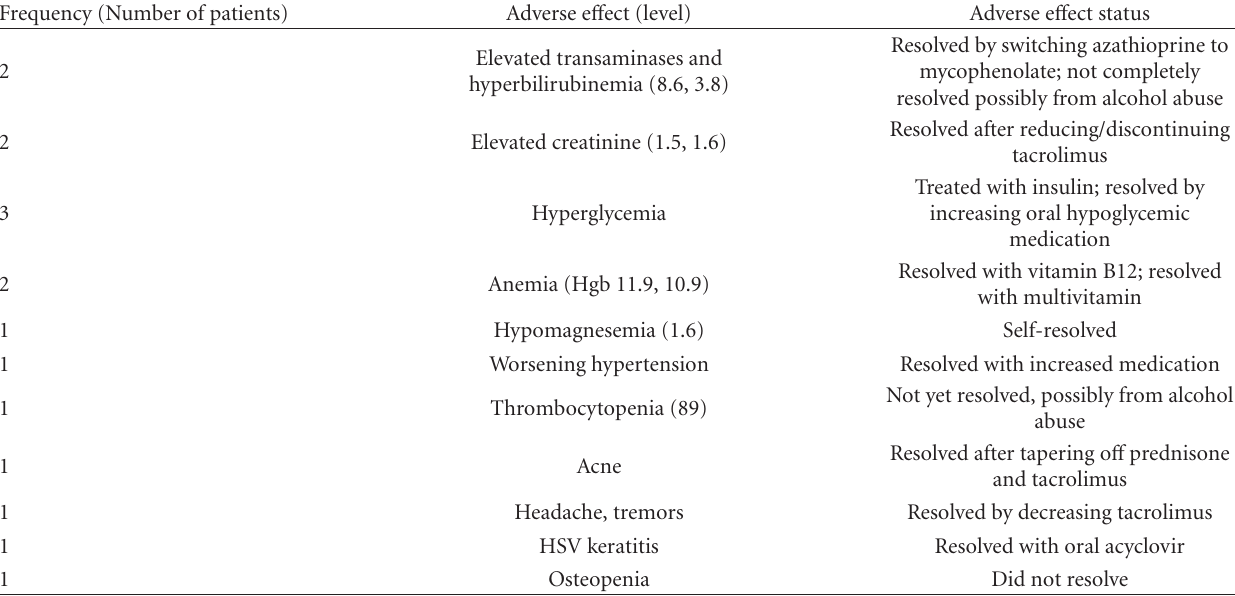
Table 2: Adverse e ff ects of systemic